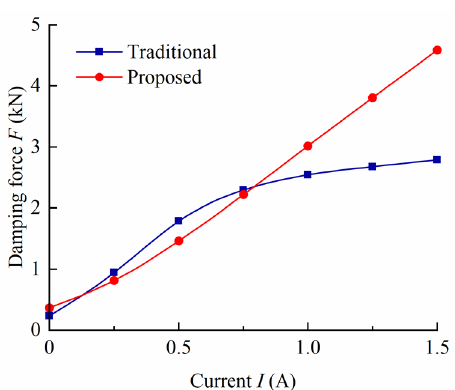
Figure 11. Comparison of the damping force of the traditional damper and the proposed damper under different applied currents.